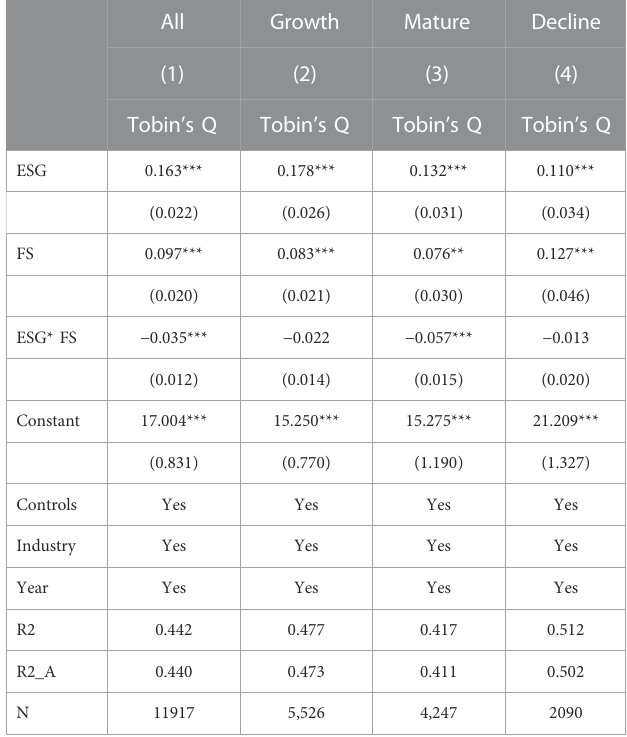
TABLE 15 The moderate effect of corporate information disclosure quality. TABLE 16 The moderate effect of corporate fi nancial slack.